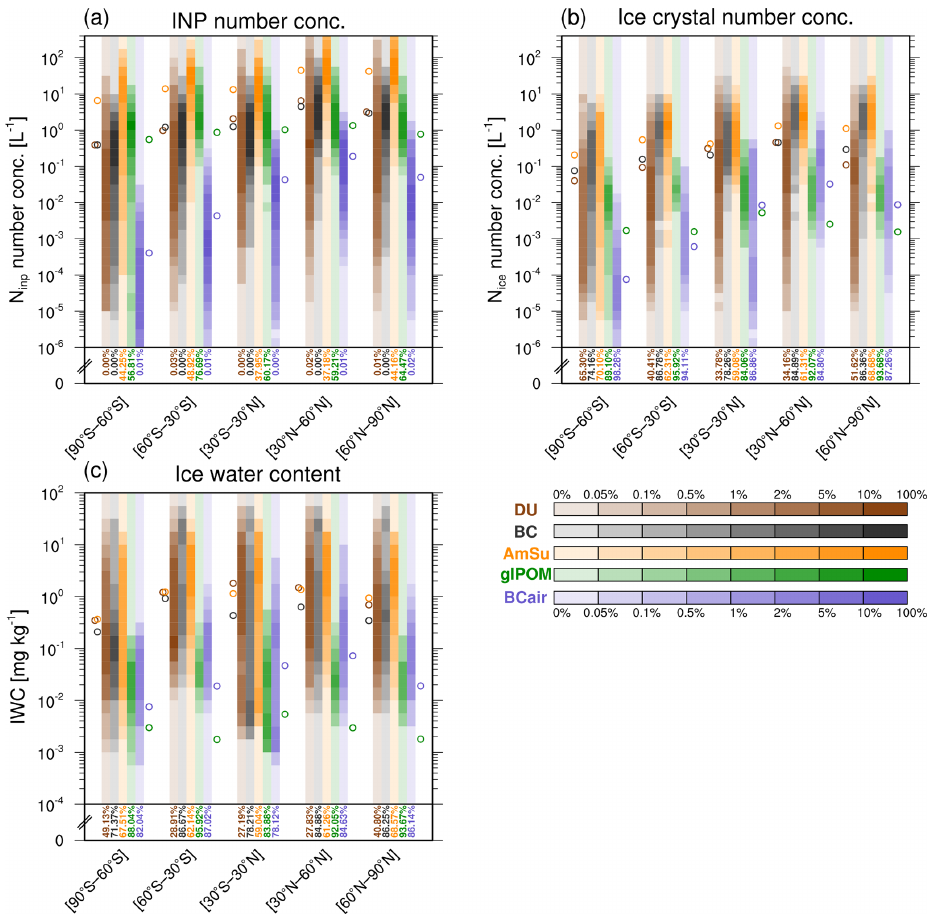
Figure 6. Frequency distributions of (a) simulated INP number concentrations (L − 1 ) as well as (b) number concentrations ( N ice ; L − 1 ) and (c) ice water content (IWC; mgkg − 1 ) of pristine ice crystals inside cirrus clouds per freezing mode for five different latitude regions, calculated from 11h model output for the simulation period (2010–2019). Shaded colours represent the frequency of occurrence within specific bins for the respective variable considering four logarithmic bins per order of magnitude. The different colours refer to DU (brown), BC (black), AmSu (orange), glPOM (green), and BCair (purple). Frequencies in the bottom bin, including all values down to zero, are depicted as coloured text. Cirrus conditions are selected according to temperature ( T < 238K) and ice water content (IWC > 0.5mgkg − 1 ) in every model grid box and time step. Additionally, only grid boxes without ice formation on pre-existing ice crystals are selected ( N preex < 10 − 23 L − 1 ). The number concentrations of potential INPs are weighted with ice-active fractions from laboratory measurements ( f act at S i = 1 . 4; see Table 1). Open circles to the left and right of every latitude region denote mean values for the different INP